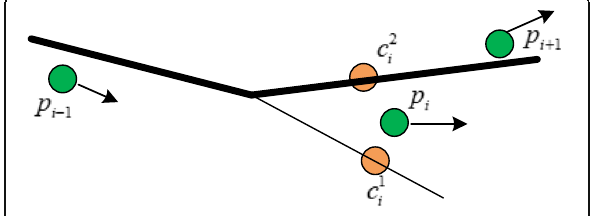
Fig. 6 An example of